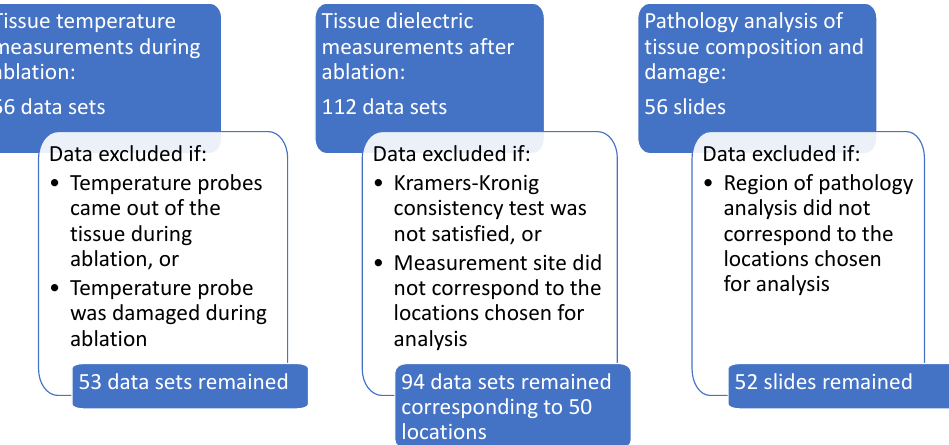
Figure 4. Data acquired and criteria for